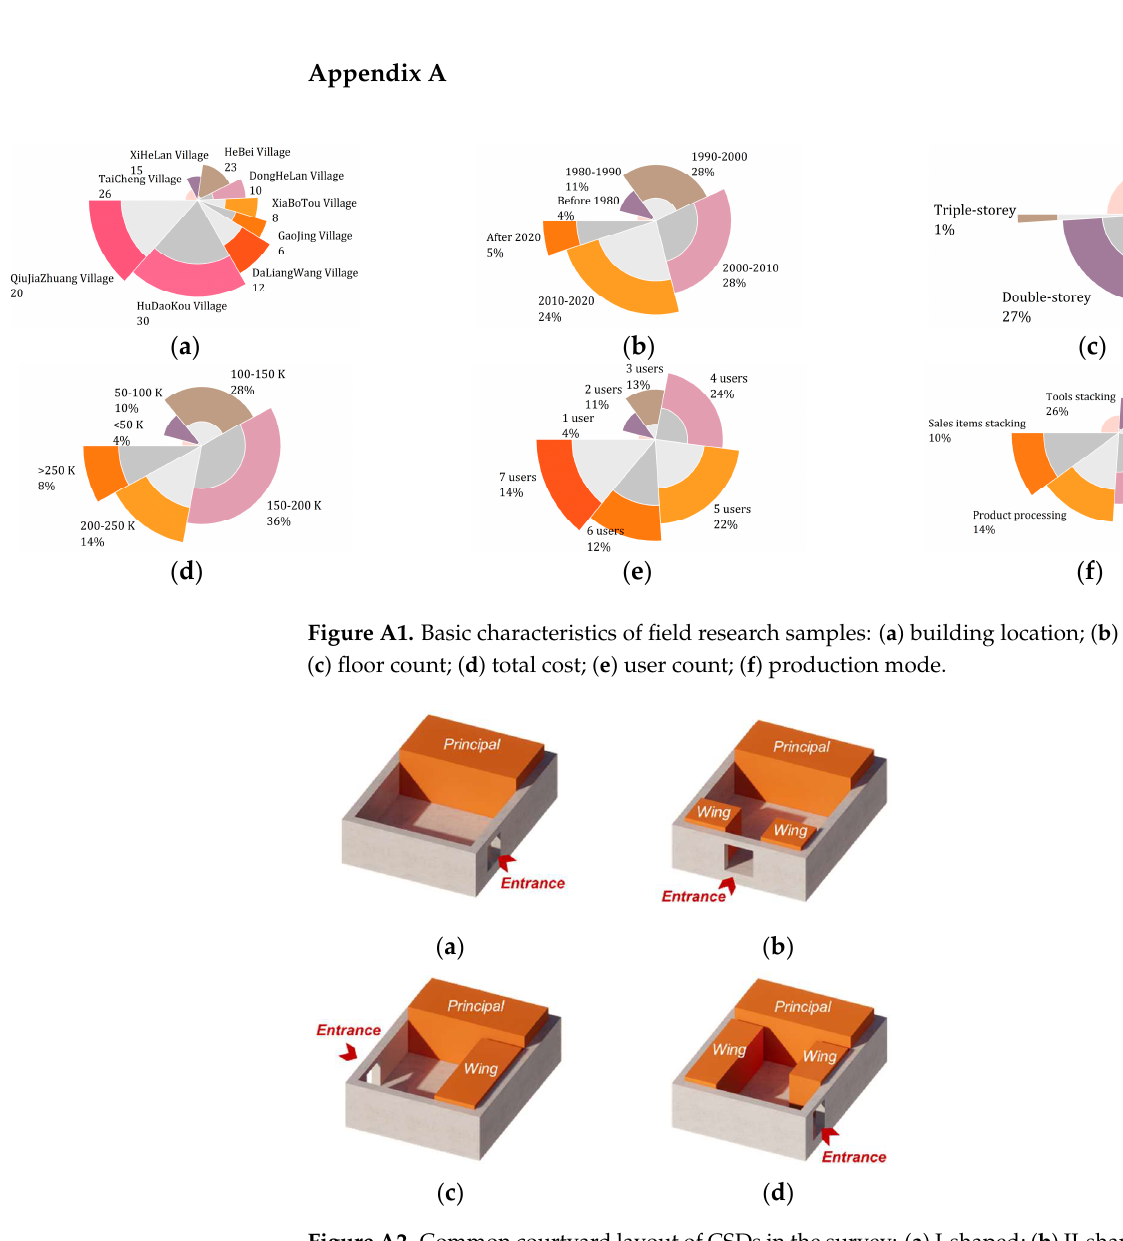
Figure A2. Common courtyard layout of CSDs in the survey: ( a ) I-shaped; ( b ) II-shaped; ( c ) L-shaped; ( d ) U-shaped. Table A1. Common enclosure structure form of rural houses in the